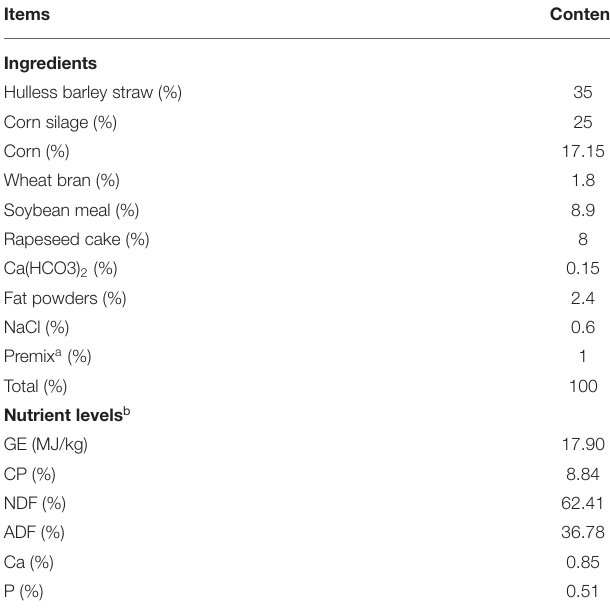
TABLE 1 | Ingredients and chemical composition of the experimental diet.